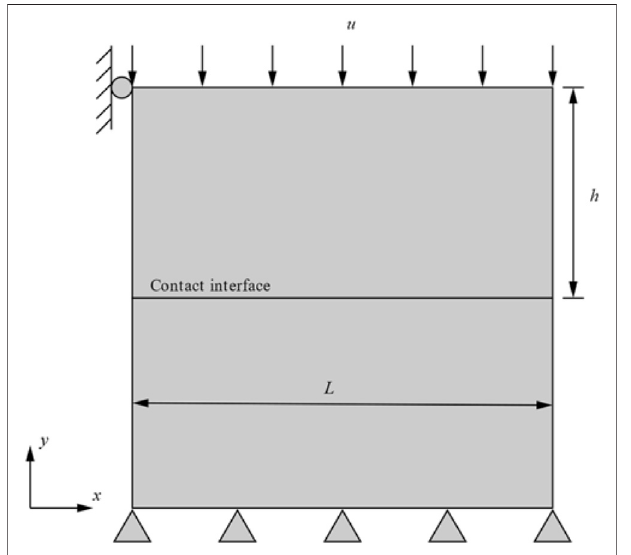
FIGURE 9 | Model geometry with straight lines in the contact interface.